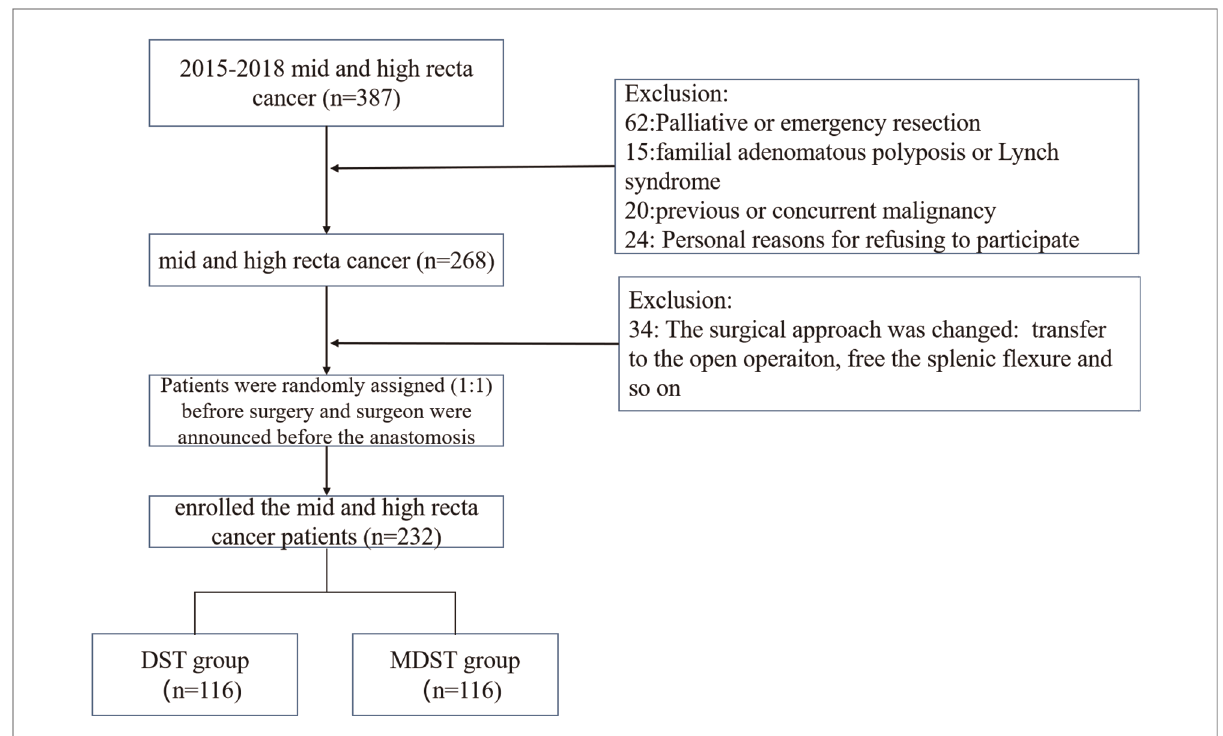
FIGURE 1 The patients fl ow